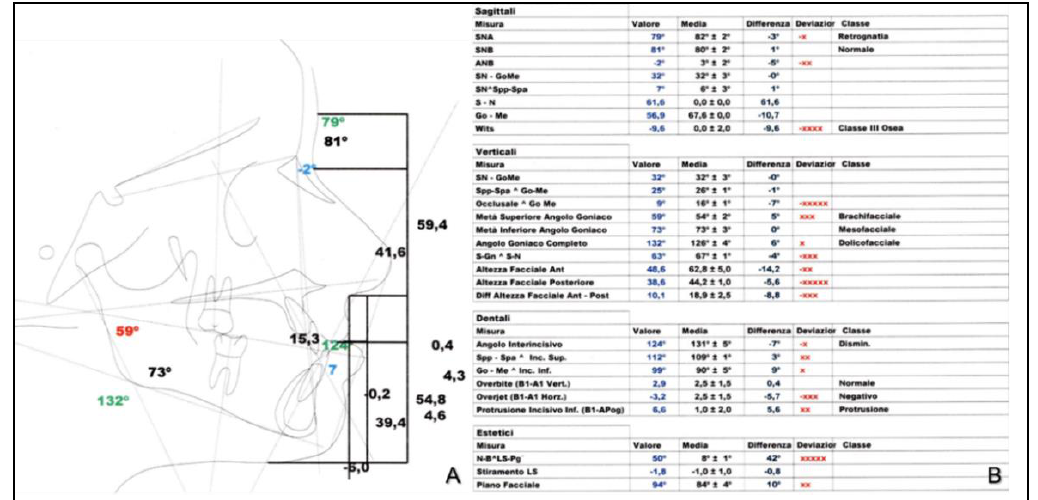
Figure 3. Cephalometric tracing ( A ) and analysis ( B ) before treatment. At the dental level, the patient had a Class III molar and canine ratio with a 124° interincisal angle and a negative OVJ of − 3.2.